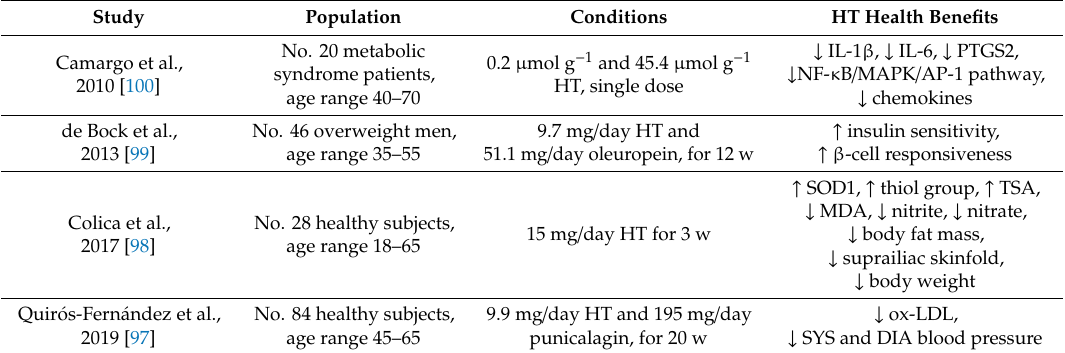
Table 3. Summary of relevant studies on HT supplementation in humans and its reported e ff